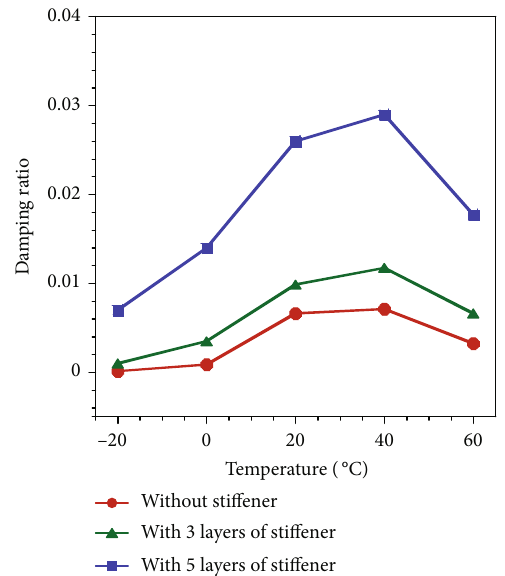
Figure 8: Damping ratio of the solar panels under various temperature conditions.